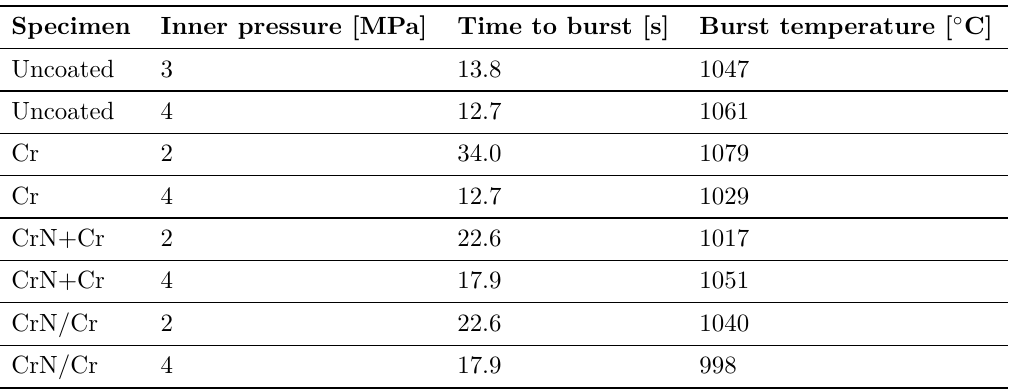
Table 2. Time to burst at temperature 1100 ◦ C in relation to the hoop stress for different types of coatings and uncoated specimens